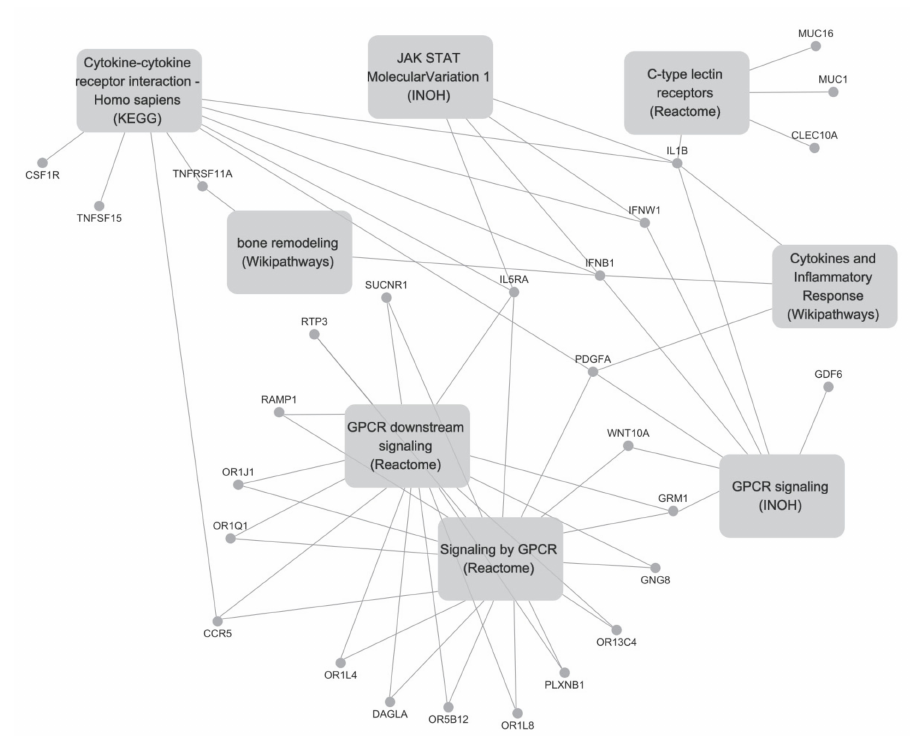
Figure 2. Network analysis between cell signaling pathways and altered genes in